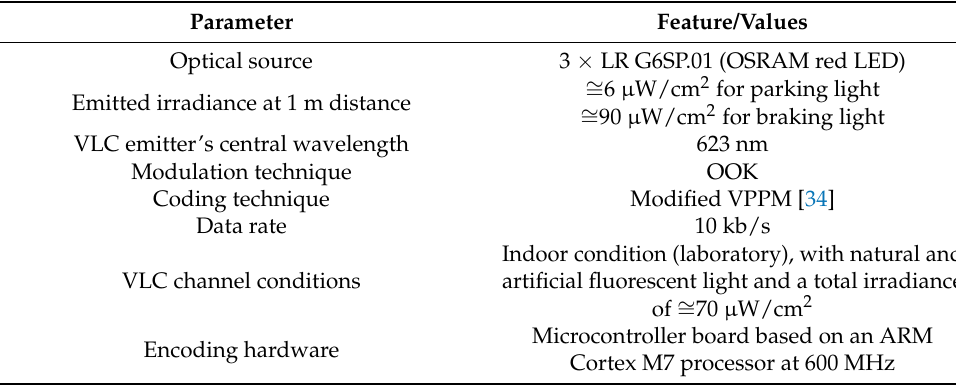
Table 2. Parameters of the VLC emitter test bench.